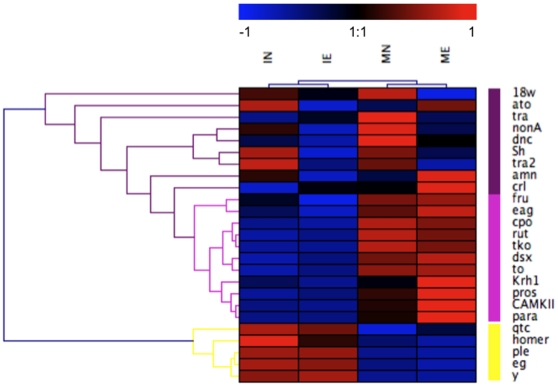
Gene expression profiles of age and experience categories.Single factor hierarchical clustering of expression profiles; red indicates increased expression, blue indicates decreased expression (as compared to the mean standardized expression taken over all genes and treatments). Three distinct clusters were found, and are identified by the color bars on the right. These clusters are discussed in the text. Full gene names are listed in Table 1.